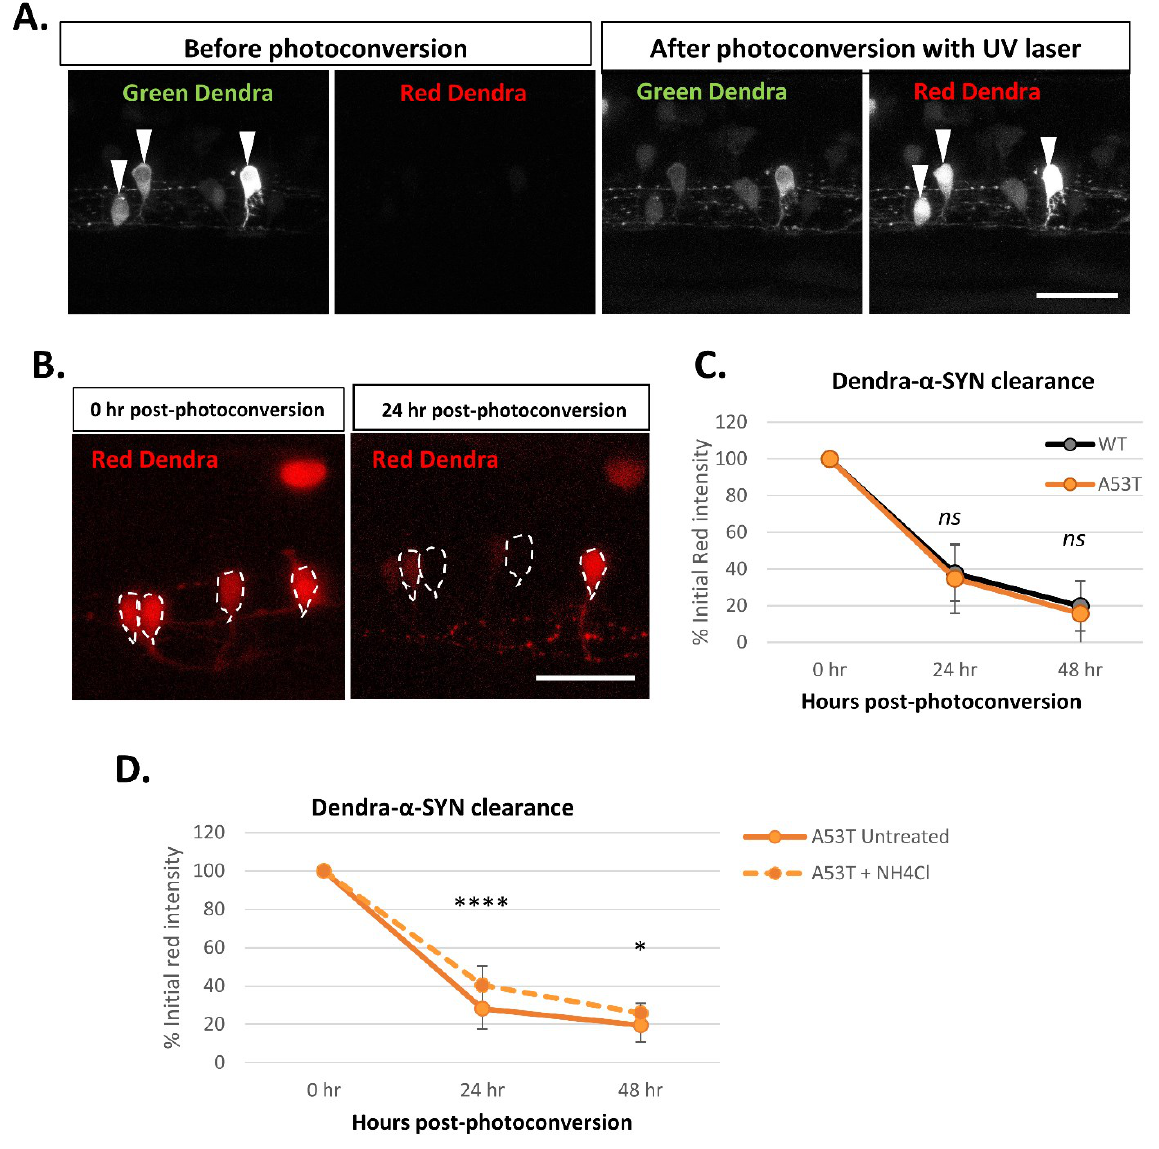
Figure 5. Dendra- α -SYN clearance kinetics in vivo. ( A ) Confocal images of the green and red fluorescent signal of Dendra- α -SYN in isolated neurons in the spinal cord of fish with mosaic expression of Dendra- α -SYN-A53T. Neurons with transgene-expression can be identified by its dendra-derived green signal. After UV (405 nm) exposure targeting the soma of selected neurons (white arrowheads), part of Dendra protein is photoconverted from green to red. As a consequence, the pool of green protein is reduced and red Dendra- α -SYN can be visualised. Scale bar represents 50 µ m. ( B ) Confocal images showing the reduction in the red signal of photoconverted Dendra- α -SYN-A53T over time. Newly synthesised Dendra- α -SYN protein is green, whereas red signal corresponds to the residual red photoconverted- protein after UV exposure. Red signal within neurons (delimited by dashed-lines) reduces over time as a consequence of its degradation and can be used as a readout for clearance kinetics. Scale bar represents 50 µ m. ( C ) Graph representing the decrease in the red-Dendra intensity in single neuronal cells in the spinal cord of Dendra- α -SYN-wt and A53T fish with mosaic expression. Dendra- α -SYN-wt and A53T clear at the same rate (N ≧ 30 neurons per group). ( D ) Changes in the clearance rate of Dendra- α -SYN-A53T after inhibition of autophagic flux by ammonium chloride (NH 4 Cl). NH 4 Cl delays the clearance of Dendra- α -SYN-A53T ( N = minimum 30 neurons per group; * p < 0.05, **** p < 0.0001 vs . untreated α -SYN-A53T).